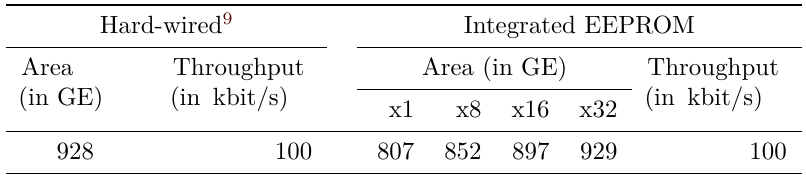
Table 5: Implementation results for Plantlet considering that the key is continuously read from different types of NVM